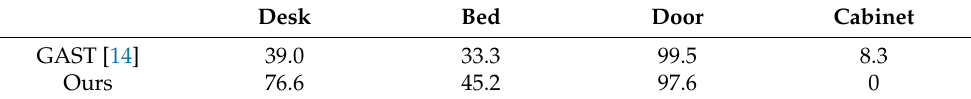
Table 5. Part of category-wise classification accuracy (%) on the M11 → S*O11 scenario.